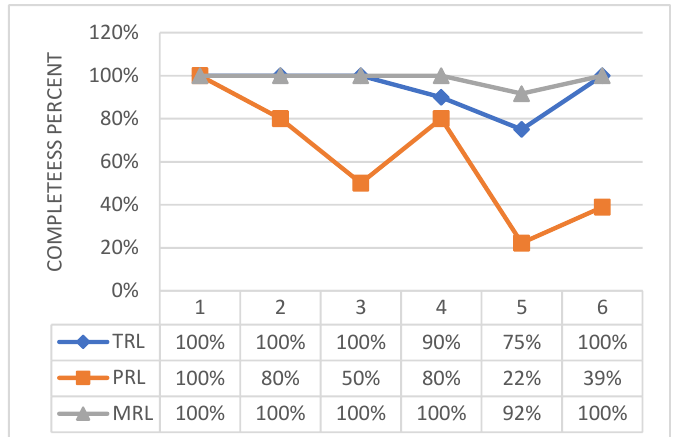
Figure 18. Technological, programmatic, and manufacturing level of maturity of the shape adaptive blade actuation system.